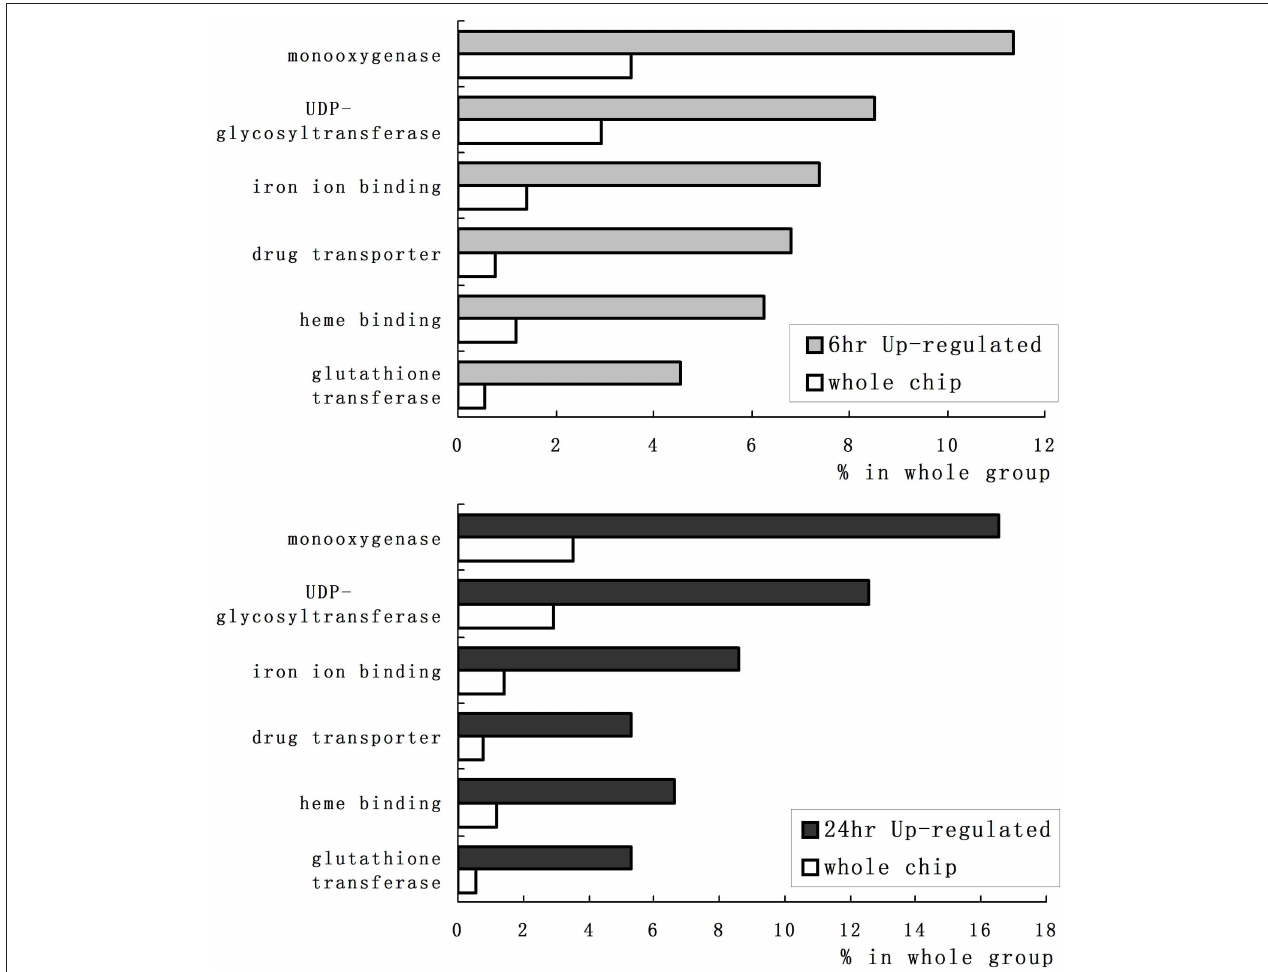
FIGURE 2 | The significantly enriched GO terms of the quinclorac-induced genes. The white bars represent the percentage of each GO terms in rice whole-genome chip, the light gray bars (top) represent the percentage of each GO terms in the quinclorac-induced genes at 6h of treatment, the dark gray bars (bottom) represent the percentage of each GO terms in the quinclorac-induced genes at 24h of treatment.